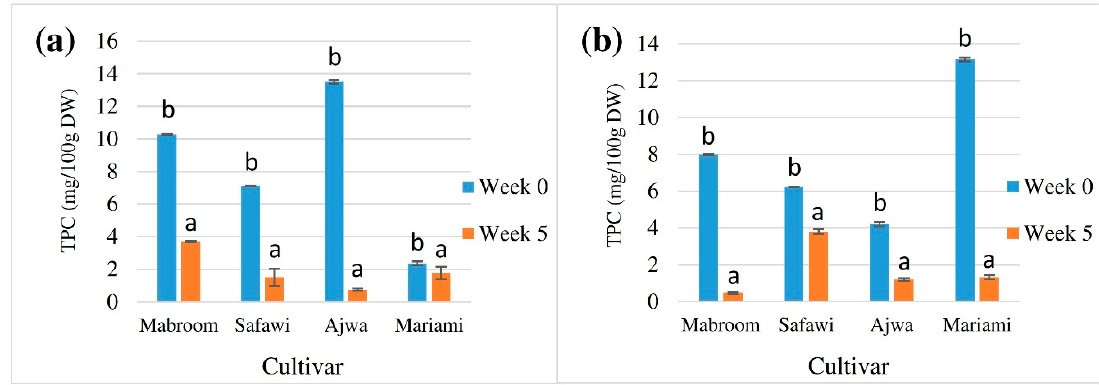
Figure 2. Effect of extract storage at − 20 °C on TPC (mg GAE/100 g DW) of four different P. dactylifera cultivars, extracted using different solvents; ( a ) extraction using methanol, ( b ) extraction using acetone. Values are the mean ± standard error of a minimum of three samples. The means with different letters on a bar differed significantly at p < 0.05 (subject to different cultivars).